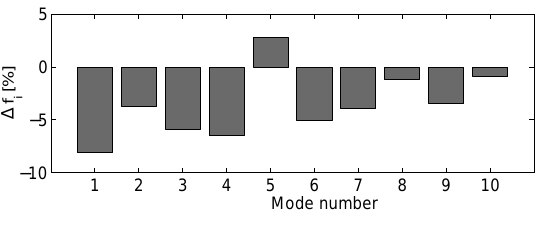
Fig. 6. Frequency deviation ( | ∆ f init | = 4 . 15% ) of the initial